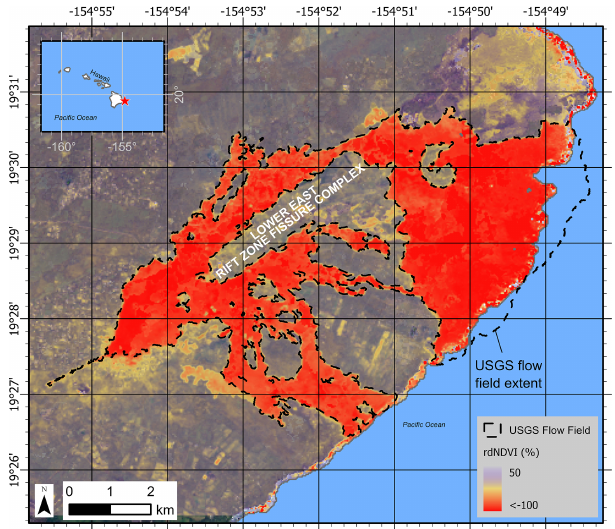
Figure 7. rdNDVI change detection images and greenest-pixel com- posites following 3 May–4 September 2018 lower east rift zone eruption of K¯ılauea Volcano, Hawaii, USA. Parameters – dataset: Landsat 8; event date: 4 September 2018; pre-window: 12 months; post-window: 6 months; maximum cloud cover: 30%; slope thresh- old: 0.05 ◦ . rdNDVI across the event illustrates loss of vegetation. Base image is post-eruption. Dashed black line is the published extent of the lava flow field (Hawaiian Volcano Observatory staff, 2018) for comparison to the HazMapper result. Notice the addi- tional landmass added to the island by the eruption that is encap- sulated by the lava flow perimeter polygon. Because there was no vegetation in this area before and after the eruption, the rdNDVI method does not account for the new landmass. In future analy- ses, however, we expect to be able to identify vegetation growth on the landmass. rdNDVI and greenest-pixel composite data exported from HazMapper, available at https://go.ncsu.edu/hazmapper-lerz (last access: 29 April